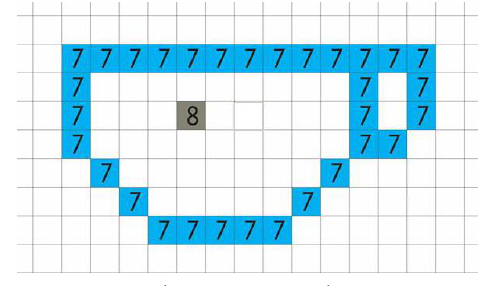
Fig. 12. Labeling example (with wrong